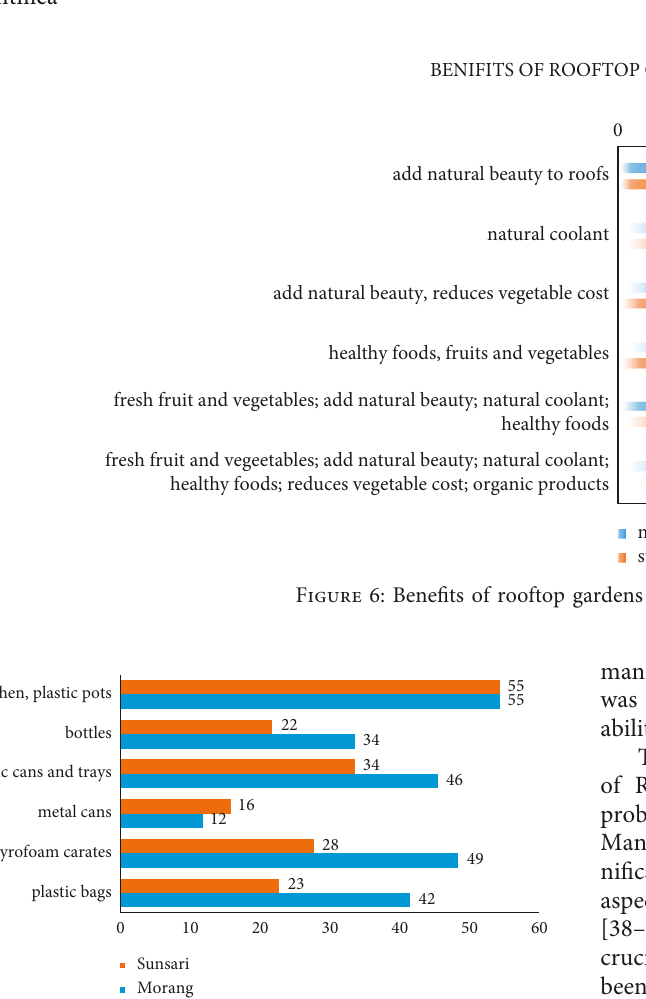
Figure 7: Use frequency of different planting materials in study